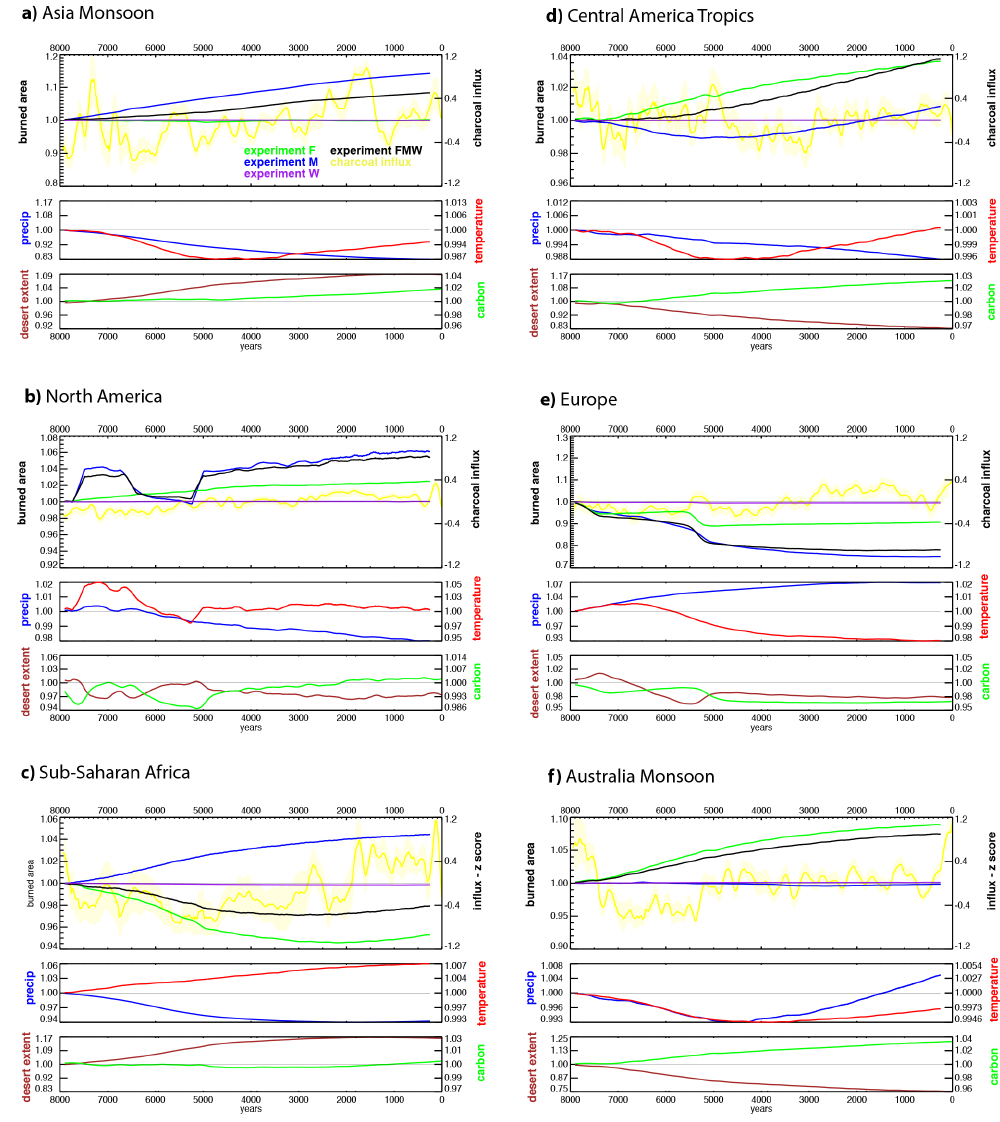
Figure 2. Transient changes in burned area between 8000 and 200calyrBP averaged over continental-scale regions (upper panels) for the experiments: FMW (black), M (blue), F (green) and W (purple). The charcoal data are presented in yellow. The lower panels show changes in climate (precipitation (blue), surface temperature (red)) and vegetation state variables (land carbon storage (green), desert extent (brown)). The definition of the domains is taken from Marlon et al. (2013). Changes are normalised with respect to the 8000calyrBP state and smoothed with a 250-year running mean similar to Brücher et al. (2014) and Marlon et al. (2013). Absolute changes for burned area and a number of external forcing factors (precipitation, surface temperature, gross primary productivity, biomass carbon, soil carbon) are shown in Fig. 2 in the Supplement of Brücher et al.